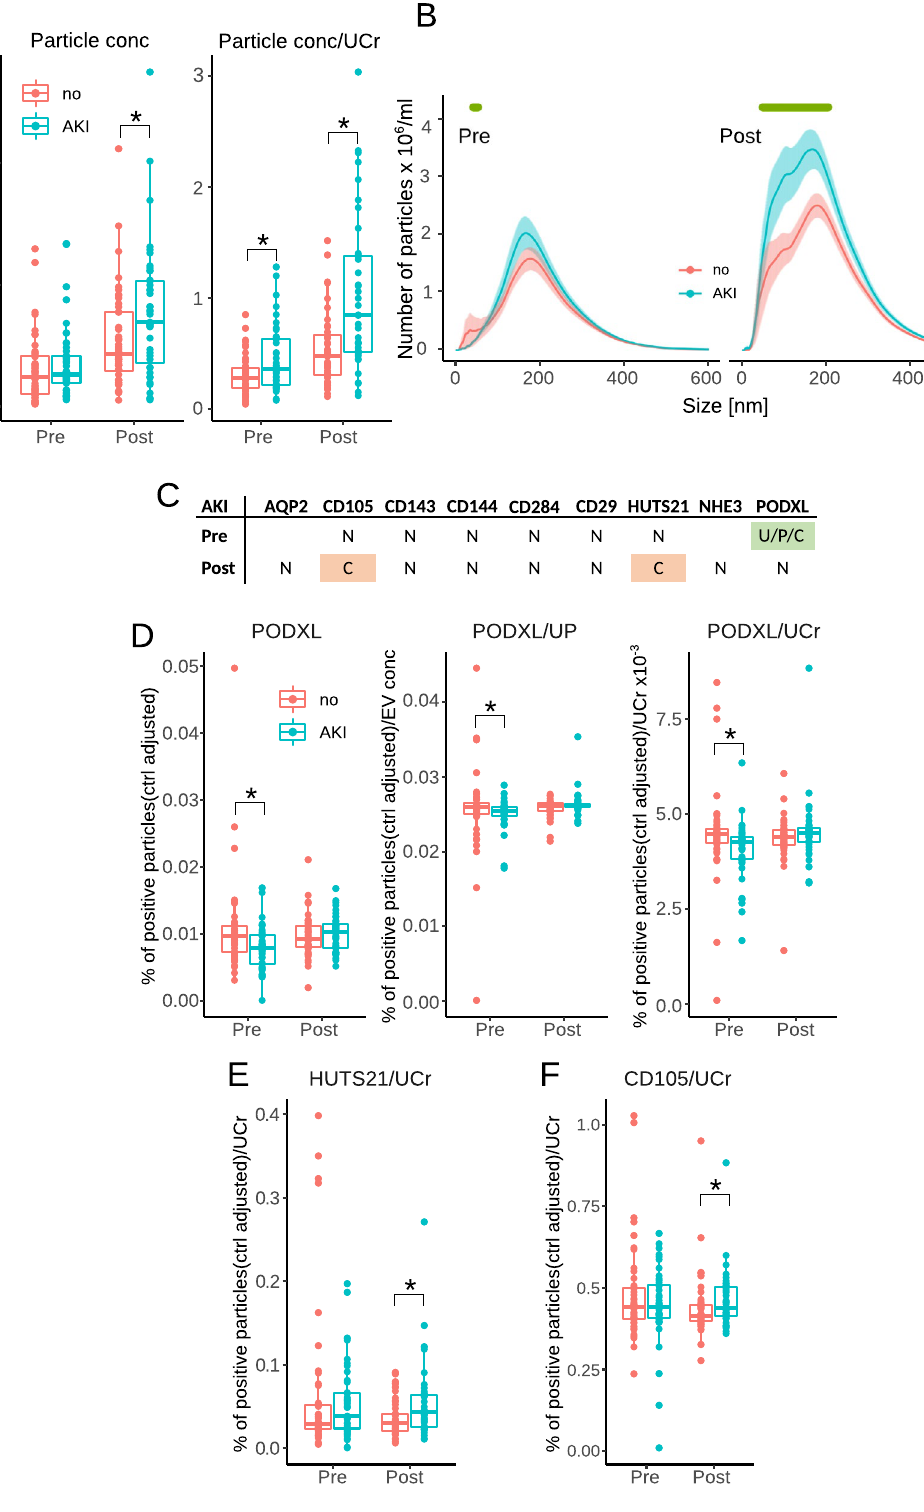
Figure 2. ( A ) Total particle concentrations in urine (unadjusted and urinary creatinine concentrations- adjusted). ( B ) Size distribution of urinary particle concentrations. Green bars indicate a significant difference between no-AKI and AKI at each particle size. ( C ) Summary of statistical analysis of EV using unadjusted (U), urinary particle (P) or urinary creatinine-adjusted (C) data. Green fields indicate a significant difference for all three adjustments and pink for one adjustment. N indicates no significant difference. ( D ) Plots of EV positive for PODXL, ( E ) activated β1-integrin (HUTS21 and ( F ) CD105. UCr indicates that the data were adjusted for urinary creatinine. Asterisks indicate a significant difference between AKI and non-AKI groups ( p <